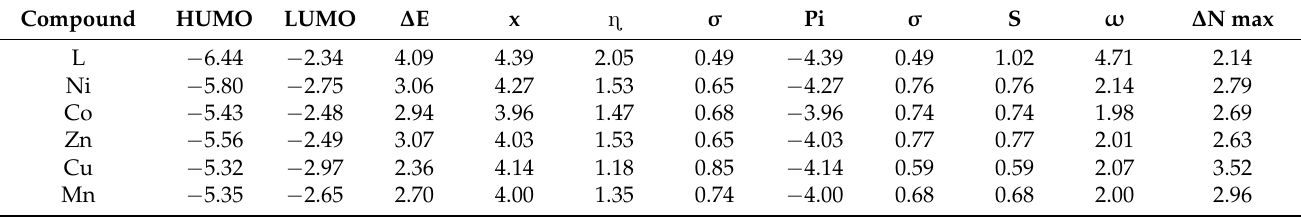
Table 2. The calculated quantum chemical parameters of the ligands and their metal complexes. Compound HUMO